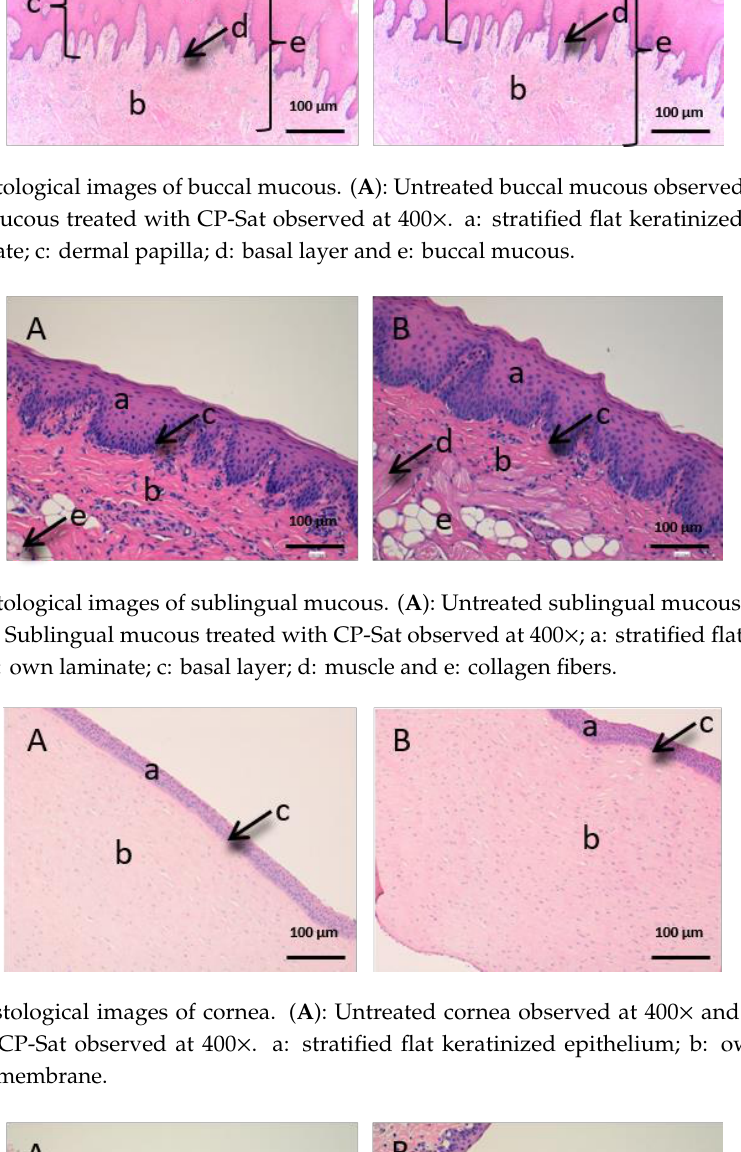
Figure 9. Histological images of cornea. ( A ): Untreated cornea observed at 400× and ( B ): Cornea treated with CP-Sat observed at 400×. a: stratified flat keratinized epithelium; b: own laminate. c: Bowman’s membrane.